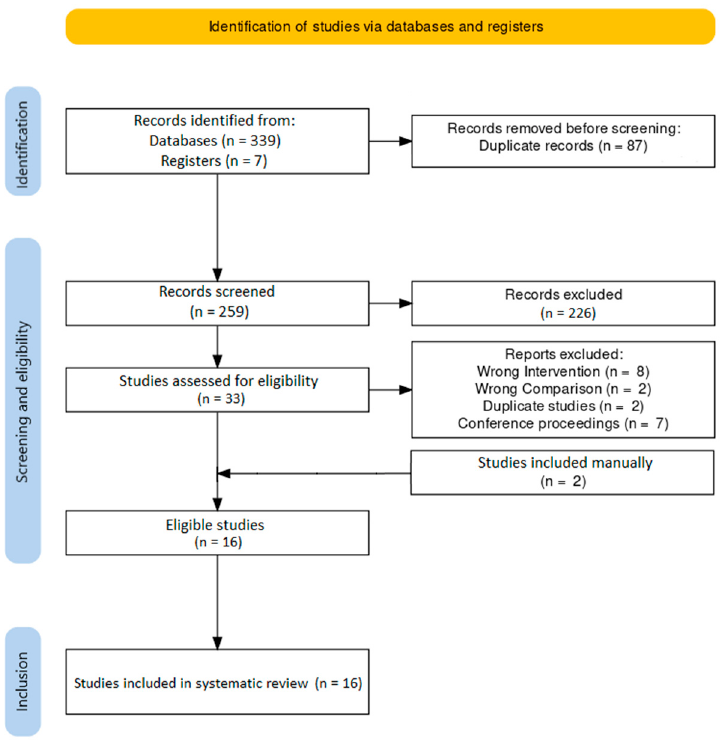
Figure 1. PRISMA flowchart.